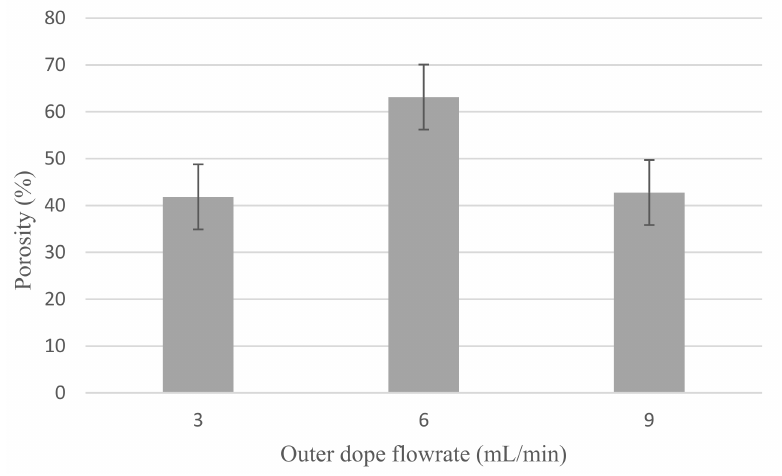
Figure 5. Porosity of 0.25 Cu 2 O/PVDF DLHF membrane for 3 mL/min, 6 mL/min and 9 mL/min outer dope